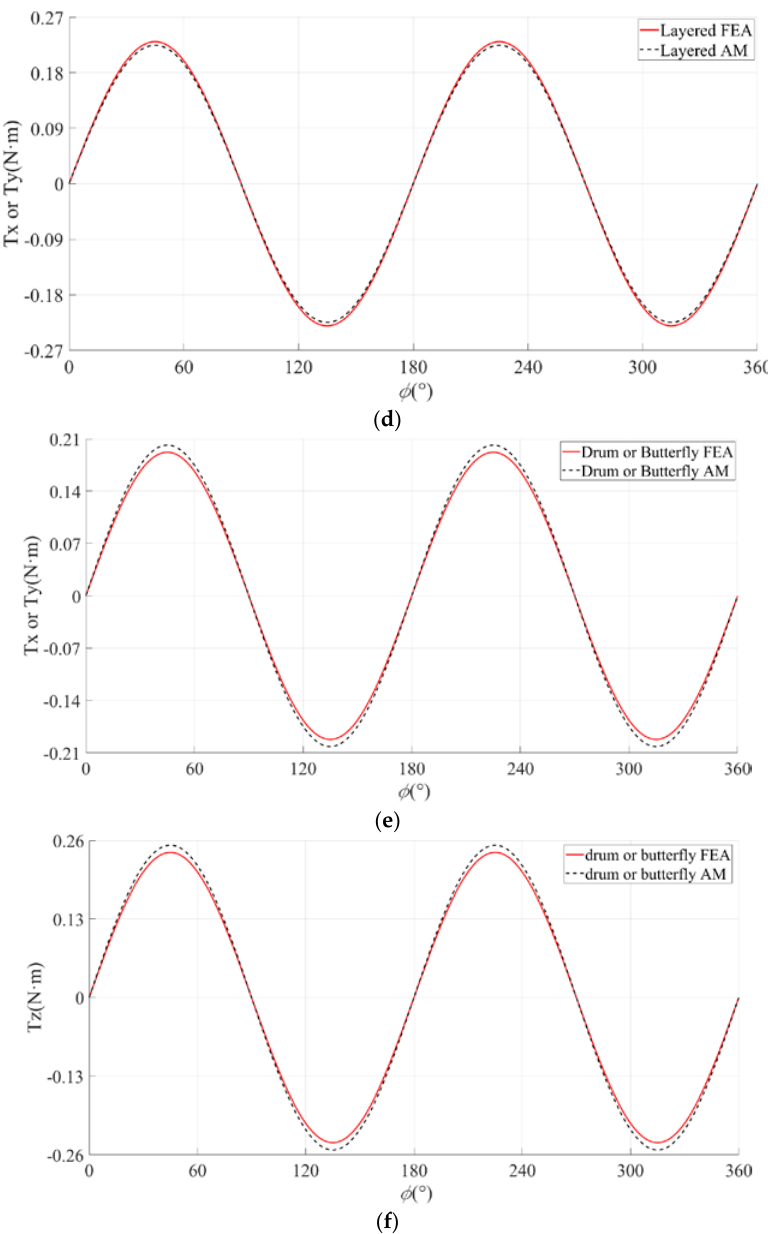
Figure 14. Torque comparison using two methods. ( a ) Rotating torque comparison between series connection Finite element method (FEM) and analytic method (AM), ( b ) rotating torque comparison between layered FEM and AM, ( c ) rotating torque comparison between drum or butterfly FEM and AM, ( d ) deflection torque comparison between series connection FEM and AM, ( e ) deflection torque comparison between layered FEM and AM, ( f ) deflection torque comparison between drum or butterfly FEM and AM.